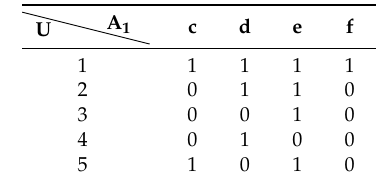
Table 2. The formal context of L β α 2.